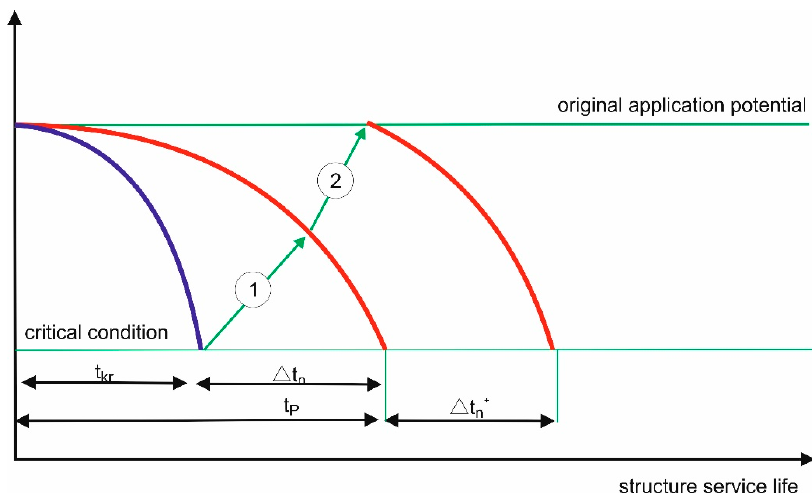
Figure 4. Schematic presentation of a repair cycle conducted as a result of a building